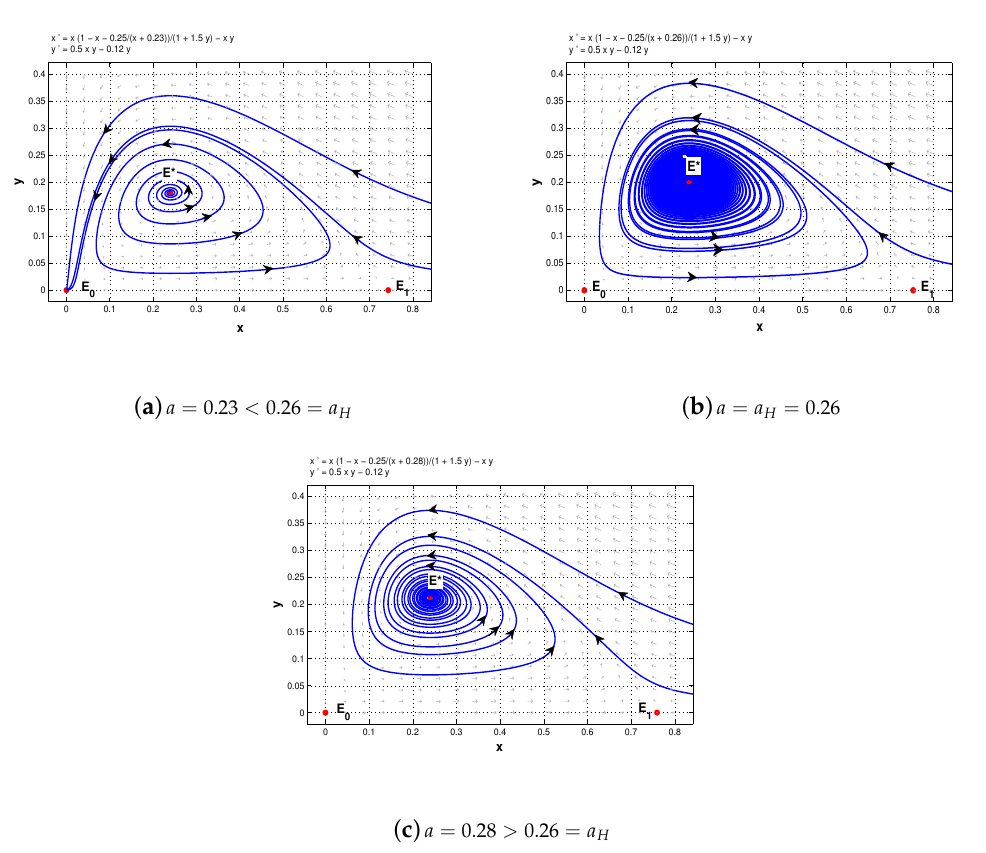
Figure 3. ( a ) When a < a H , E ∗ is unstable. ( b ) When a = a H , a stable periodic orbit bifurcated from E ∗ . ( c ) When a > a H , E ∗ is